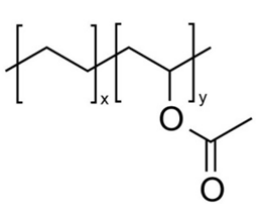
Fig. 6 Chemical composition of EVA.